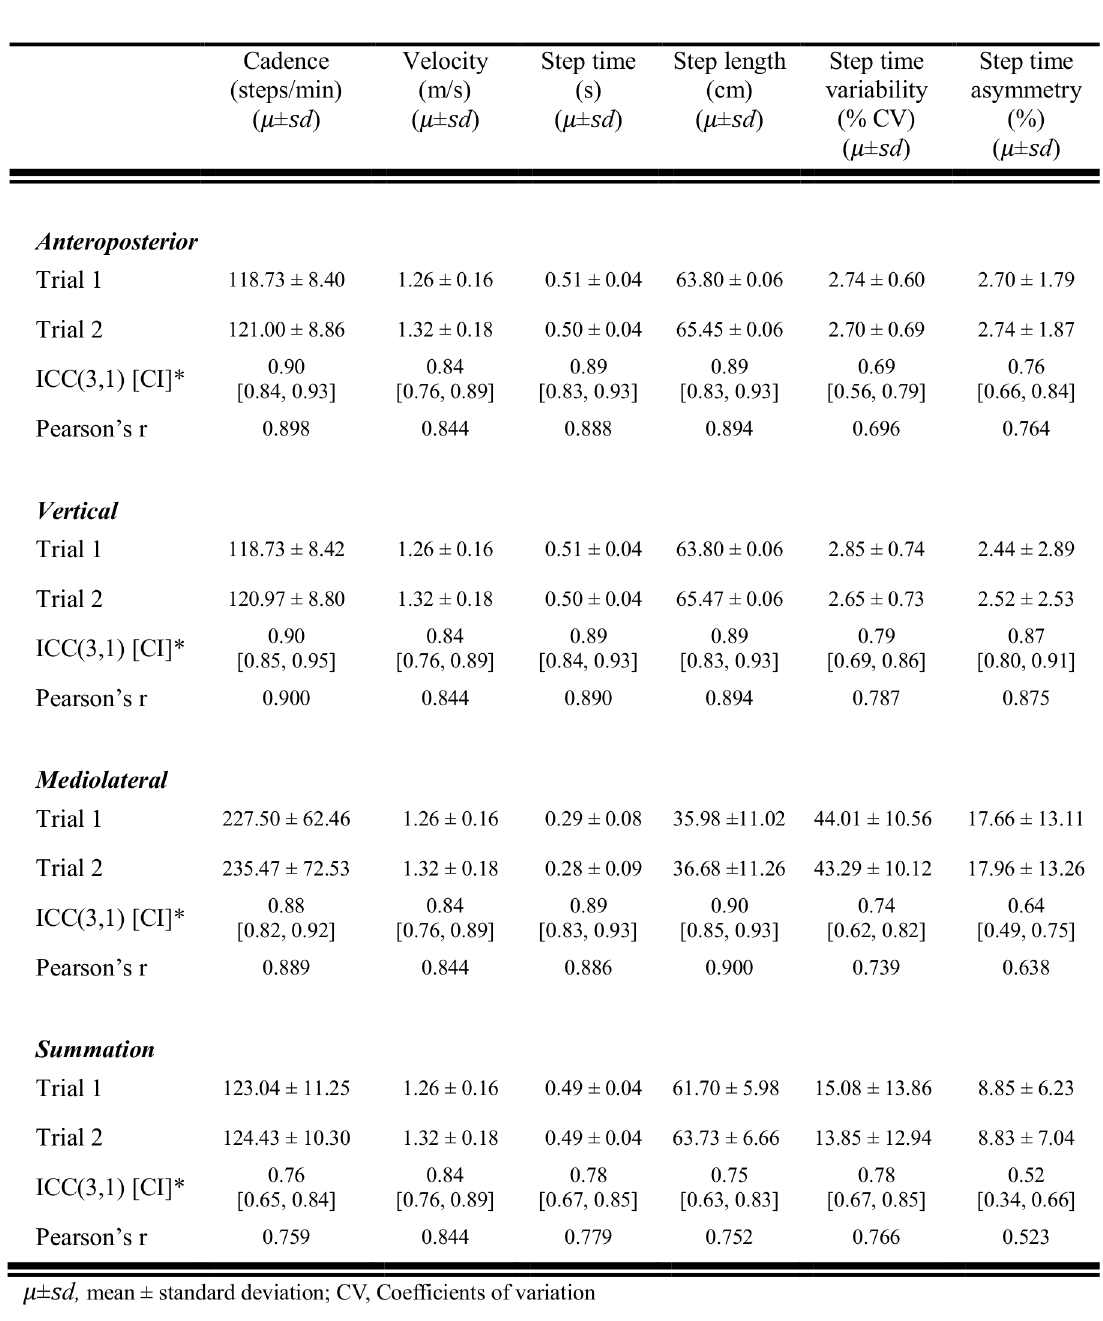
Fig 2. Test-retest reliability of the triaxial accelerometer system for spatiotemporal gait parameters.